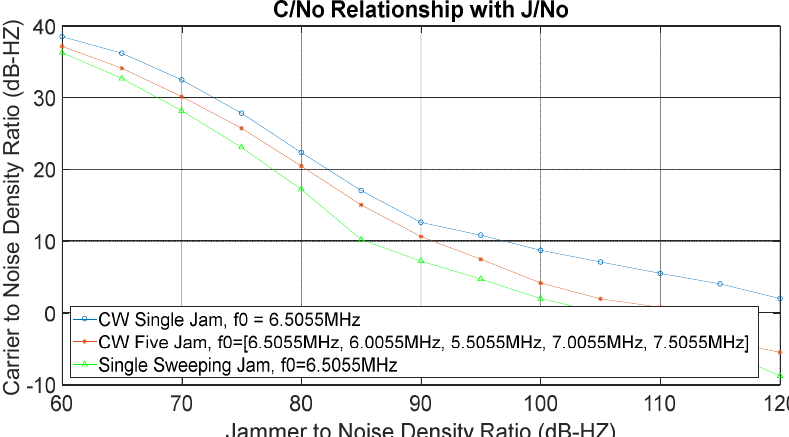
Figure 18. Averaged C/No degradation for one jammer (freqj = 6.5055 MHz), five jammers (freqj = 6.5055 to 7.5055 MHz) and sweeping bandwidth jammer (freqj =5.5 to 7.5 MHz) without the applied filter.